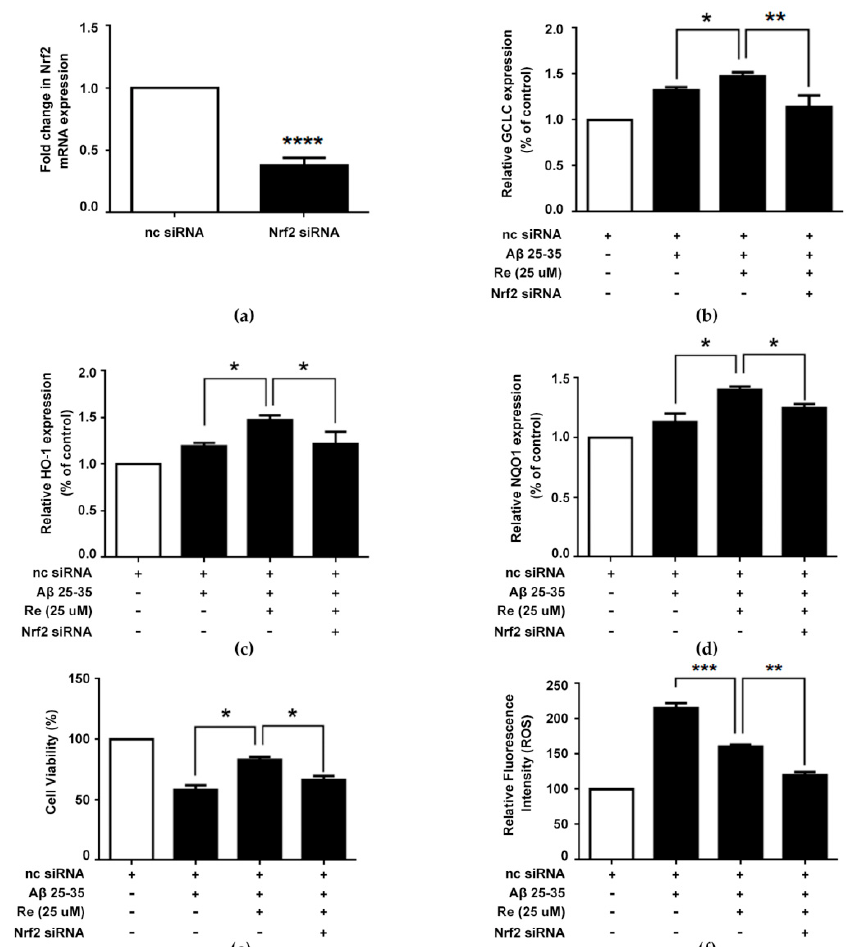
Figure 6. Ginsenoside Re alleviated A β -induced cytotoxicity and ROS generation in SH-SY5Y cells through Nrf2-dependent manner. ( a ) Nrf2 gene expression in negative control (nc) siRNA treated- and NRF2 siRNA treated group; ( b – d ) The relative mRNA expression of antioxidative enzymes were measured by qRT-PCR; ( e ) after transient transfection with or without Nrf2 siRNA plasmid, SH-SY5Y cells were treated with ginsenoside Re in the presence or absence of A β for 24 h. Cell viability was detected by CCK-8 assay; ( f ) intracellular ROS were estimated using the fluorescent probe DCFH-DA by flow